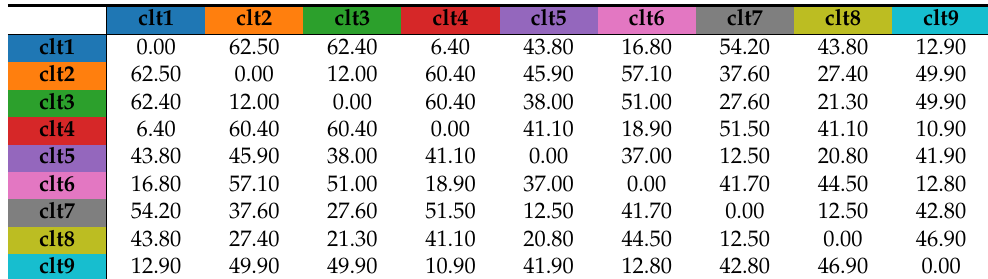
Table 4. Battery 1 pairwise KS test of the clusters. All probabilities expressed in percentages ( × 100). See Table 3 for the details about the color